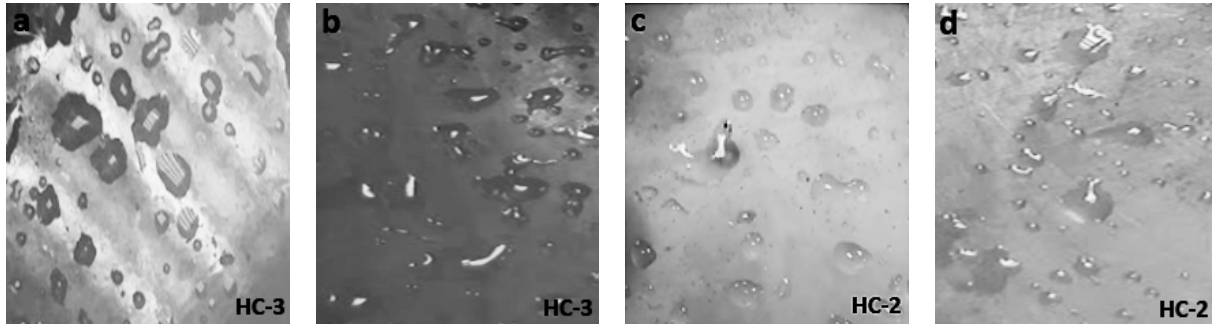
Figure 6. Images of aged (600 h) ( a ) nSiR ( b ) SMC 15 ( c ) SNC 2.5 and ( d ) SNC 5.